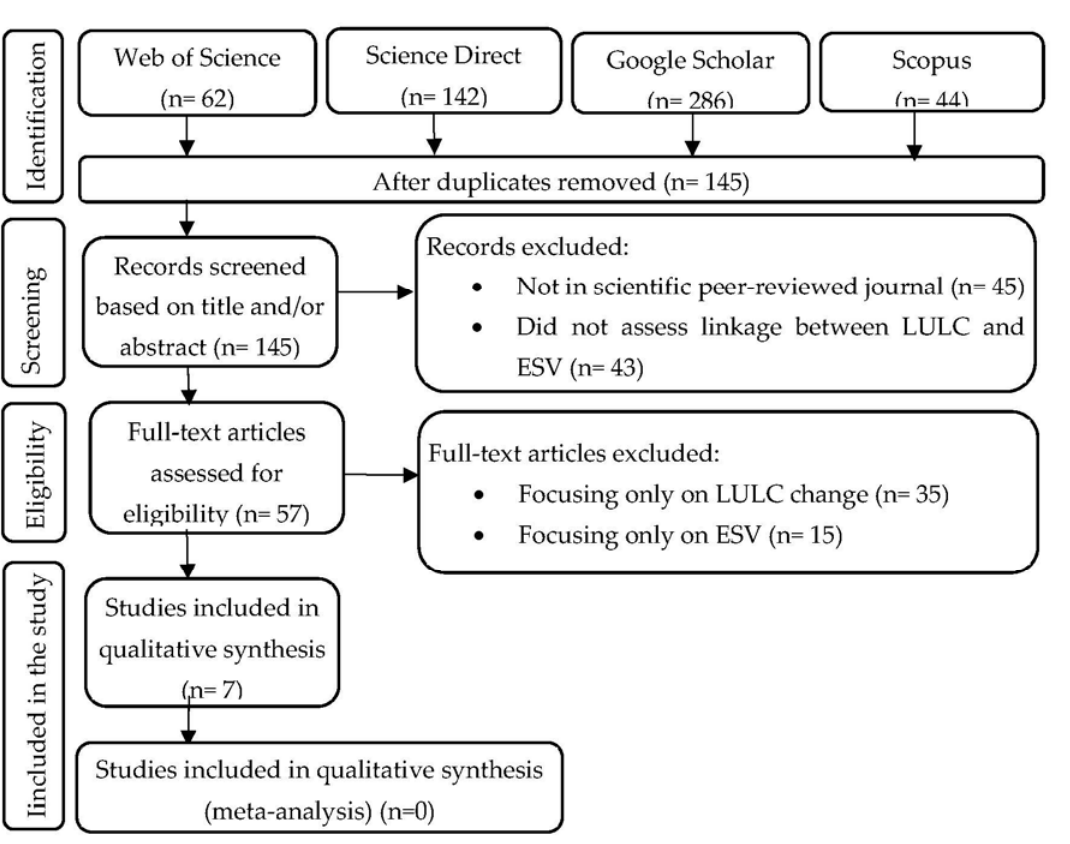
Figure 1. PRISMA flow diagram summarizing the search results and screening workflow used in this systematic review.